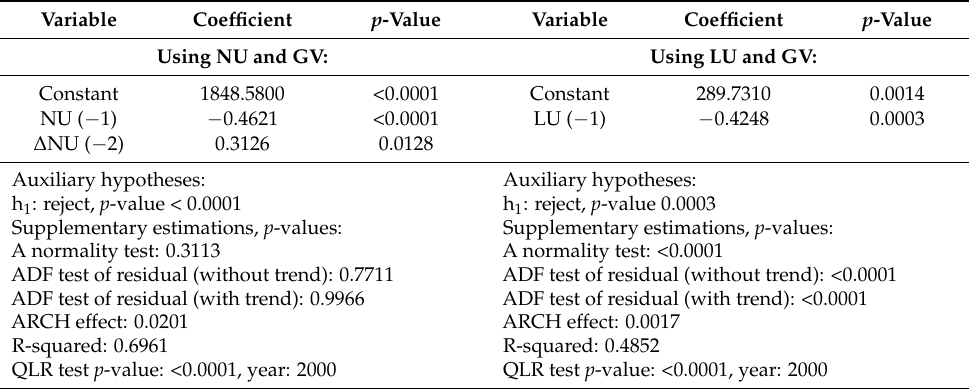
Table A2. ARDL estimations for Lithuania after eliminating insignificant variables.